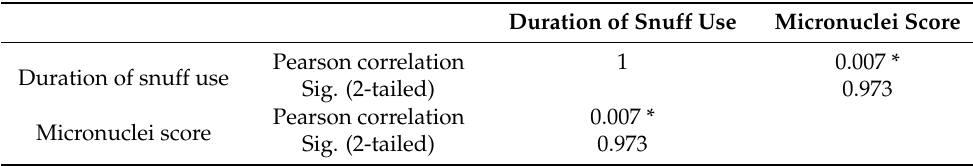
Table 6. Correlation between duration of snuff use and micronuclei